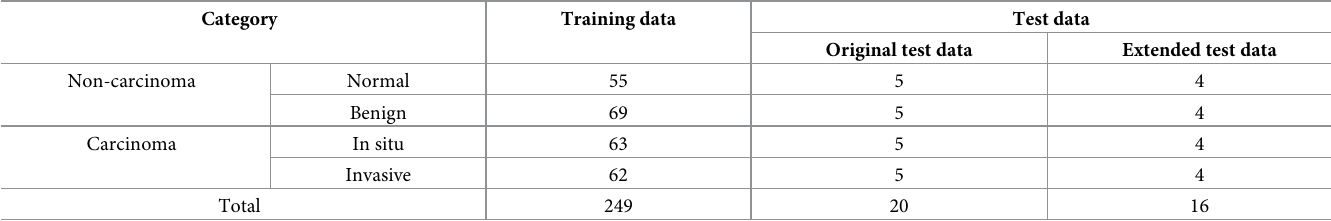
Table 1. Distribution of various histopathological images in Bioimaging 2015